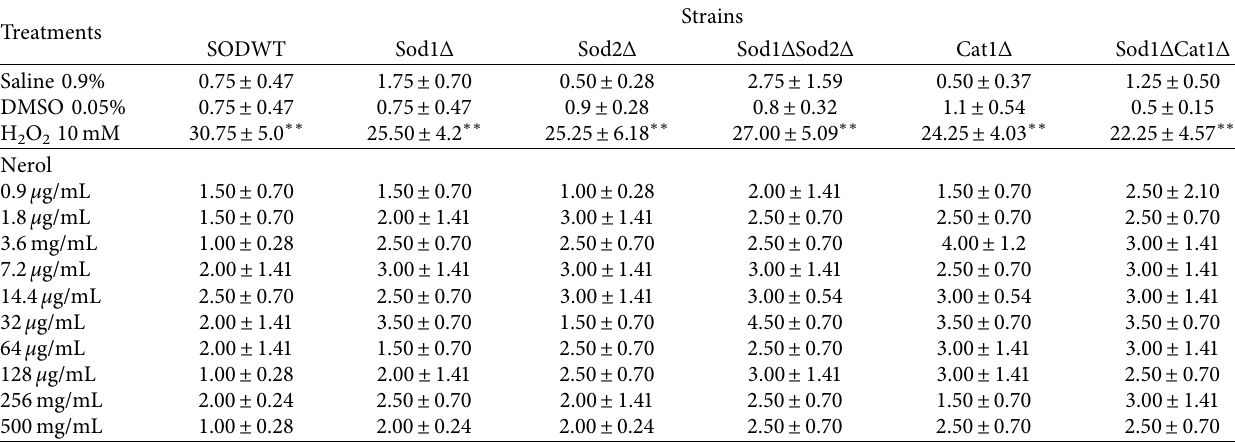
Table 4: Evaluation of oxidative damage by estragole in profcient and defcient strains of Saccharomyces cerevisiae. Treatments